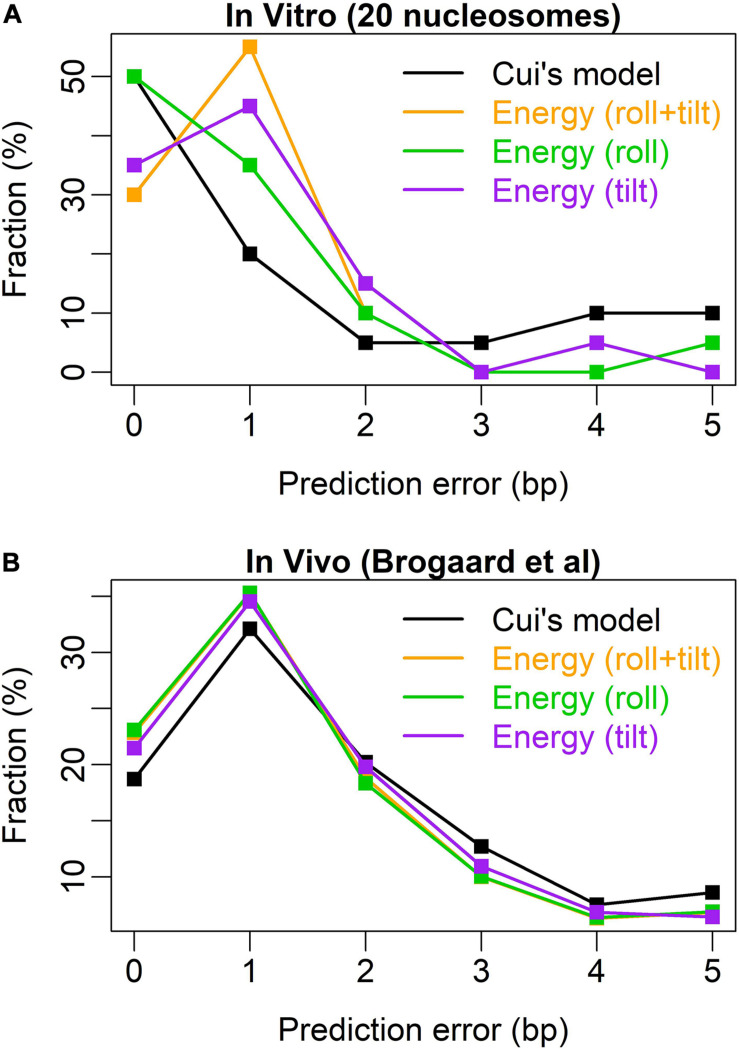
Error distribution for the prediction models. (A) Test results of 20 nucleosomes assembled in vitro (Cui et al., 2014); (B) test results of the in vivo map with base-pair resolution (Brogaard et al., 2012). Similar to Cui et al. (2014), the abscissa denotes the prediction error measured by the distance between the experimental nucleosome position and the predicted position with the lowest deformation energy in the interval [-5, +5] around the real nucleosome position. The ordinate denotes the percentage of the error class in the total predicted nucleosome positions.